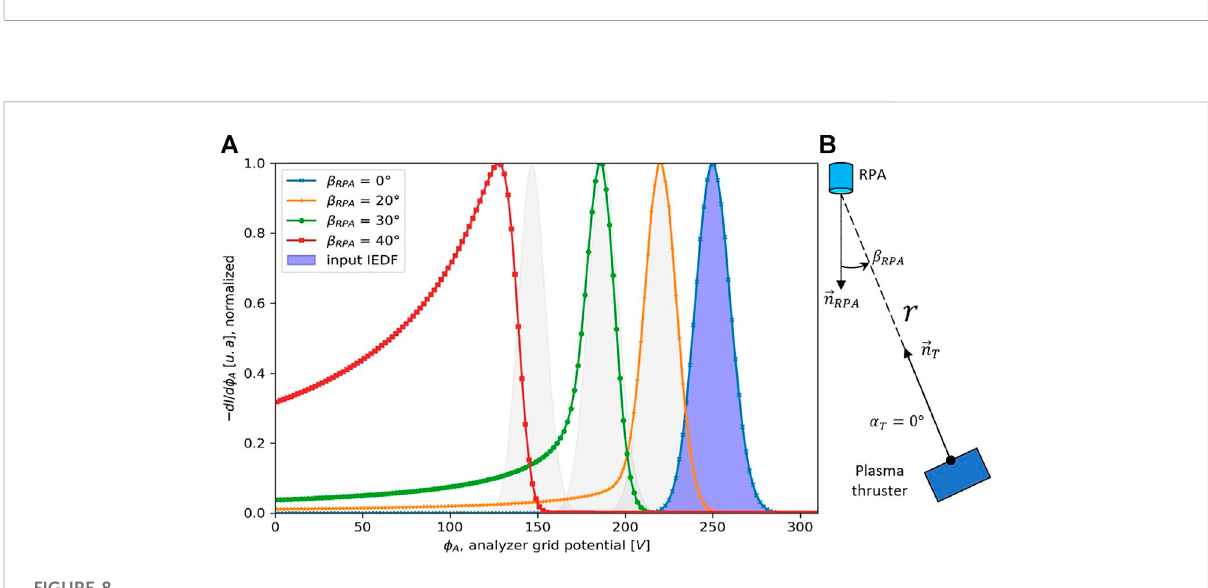
corresponds to a shifted Maxwellian distribution (cid:22) (cid:3)(cid:3)(cid:3)(cid:3)(cid:3)(cid:3)(cid:3)(cid:3)(cid:3) ) , as Eq. 3 state), with ε shift (cid:2) ε s · cos 2 ( β ( v s (cid:2) 2 ε shift / m + Xe RPA (cid:2) 40 ° , 30 ° , 20 ° . The blue area is the with from left to right, β RPA true input velocity distribution, f sm .